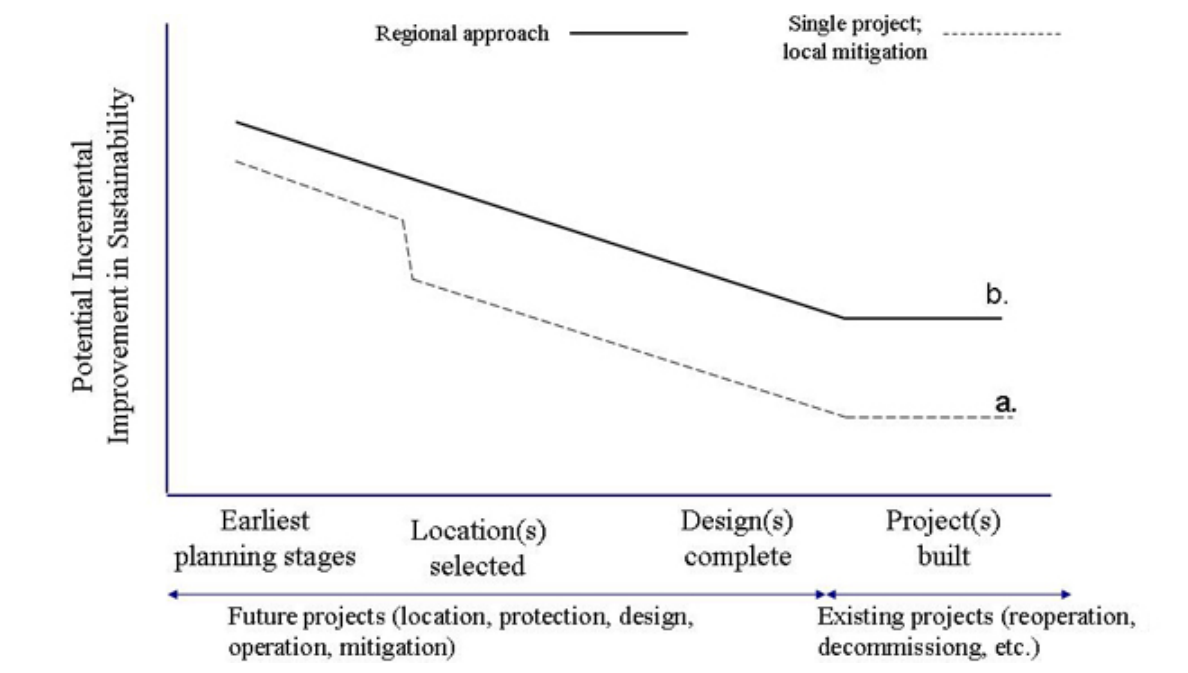
Fig. 6. A conceptual diagram of the relative potential for improving the sustainability of hydropower projects at various spatial scales and stages of development. The y-axis represents the potential incremental improvement in environmental sustainability for a given energy generation target. The greatest potential improvement occurs during initial site selection and the potential for improvement is lowest once a project is already constructed. A regional or basin-scale approach (solid line) provides a greater set of potential solutions, and thus greater potential sustainability, than a single-project approach. By adopting a basin-scale approach, the Penobscot Project moved from position “a” to position “b” on this conceptual